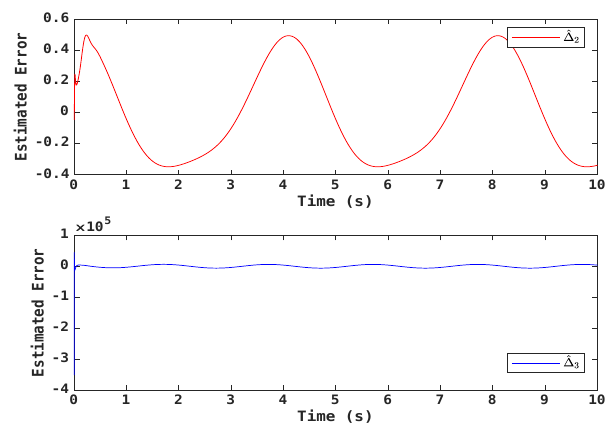
Figure 6. The estimated errors of VSDO.